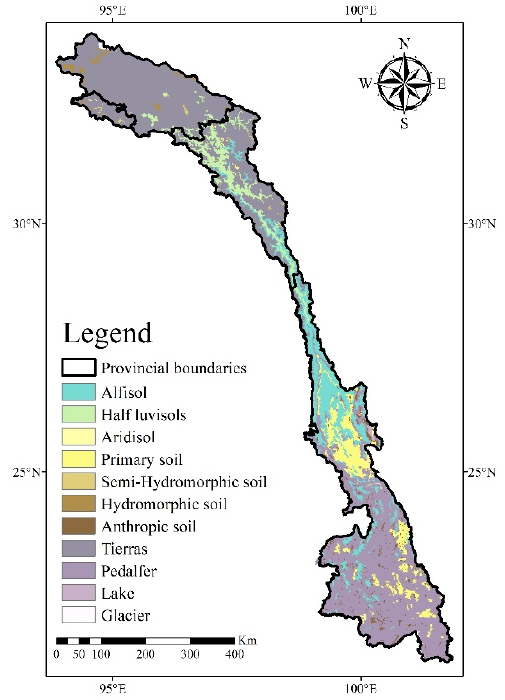
Figure 7. Soil types in the Lancang River Basin. Table 3. Change trend of NDVI of different soil types in the Lancang River Basin.